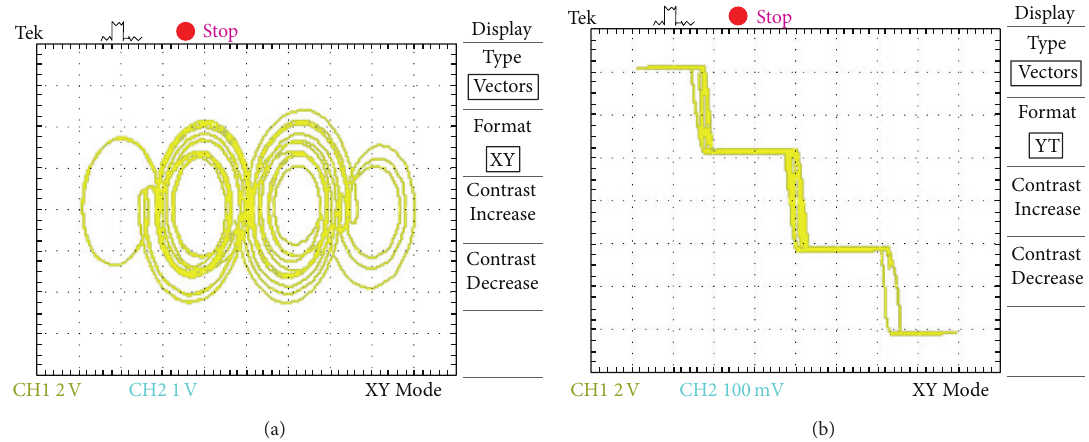
Figure 7: (a) Experimental verification of 4-scrolls in the transmitter circuit and (b) real behavior of the SNFS based on Op Amps.